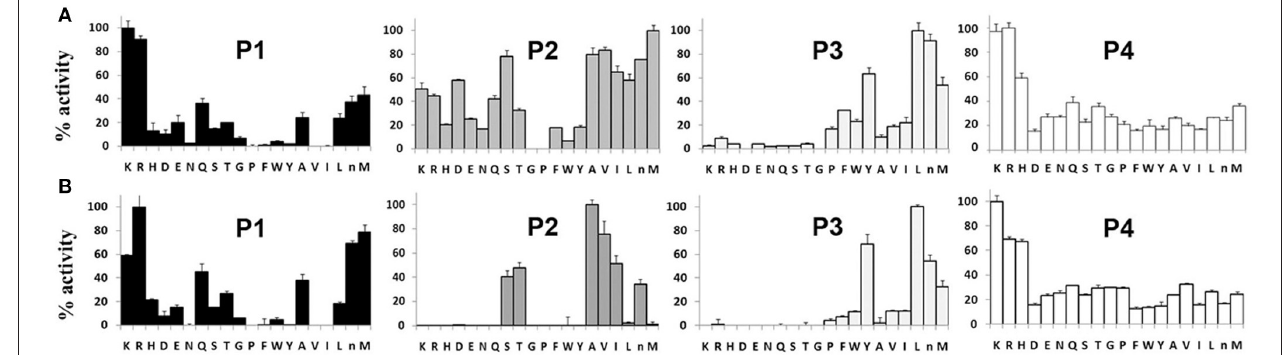
FIGURE 9 | P1–P4 amino acid preferences of pro-TrCB1.1 and pro-TrCB1.4 determined by positional scanning of a synthetic combinatorial library. (A) Substrate library of pro-TrCB1.1. (B) Substrate library of pro-TrCB1.4. P4-P1 represent the four amino acid side chains recognized by peptidase on the N-terminal side of the cleaved peptide bond. The X-axis indicates the 20 amino acids held constant at each position, designated by the single-letter code (n, norleucine). The Y-axis shows relative preference for the particular amino acid when 100% represents the most preferred amino acid